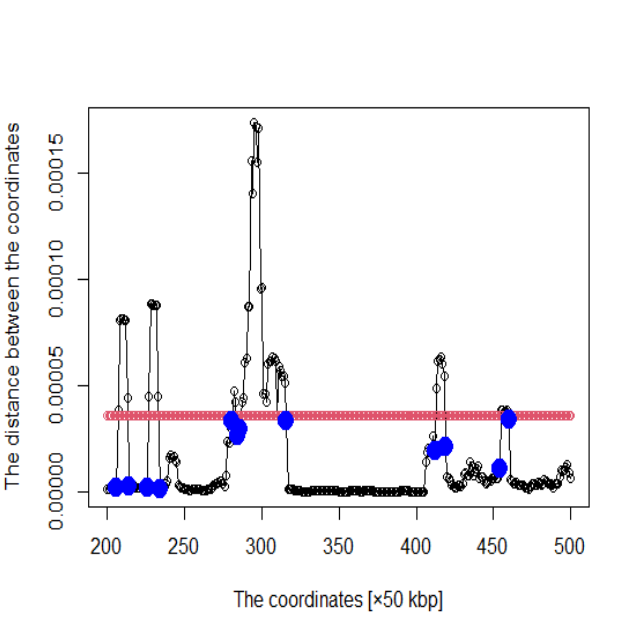
Figure 4. Distance plot between coordinates (The red line is the threshold and blue points are roots).